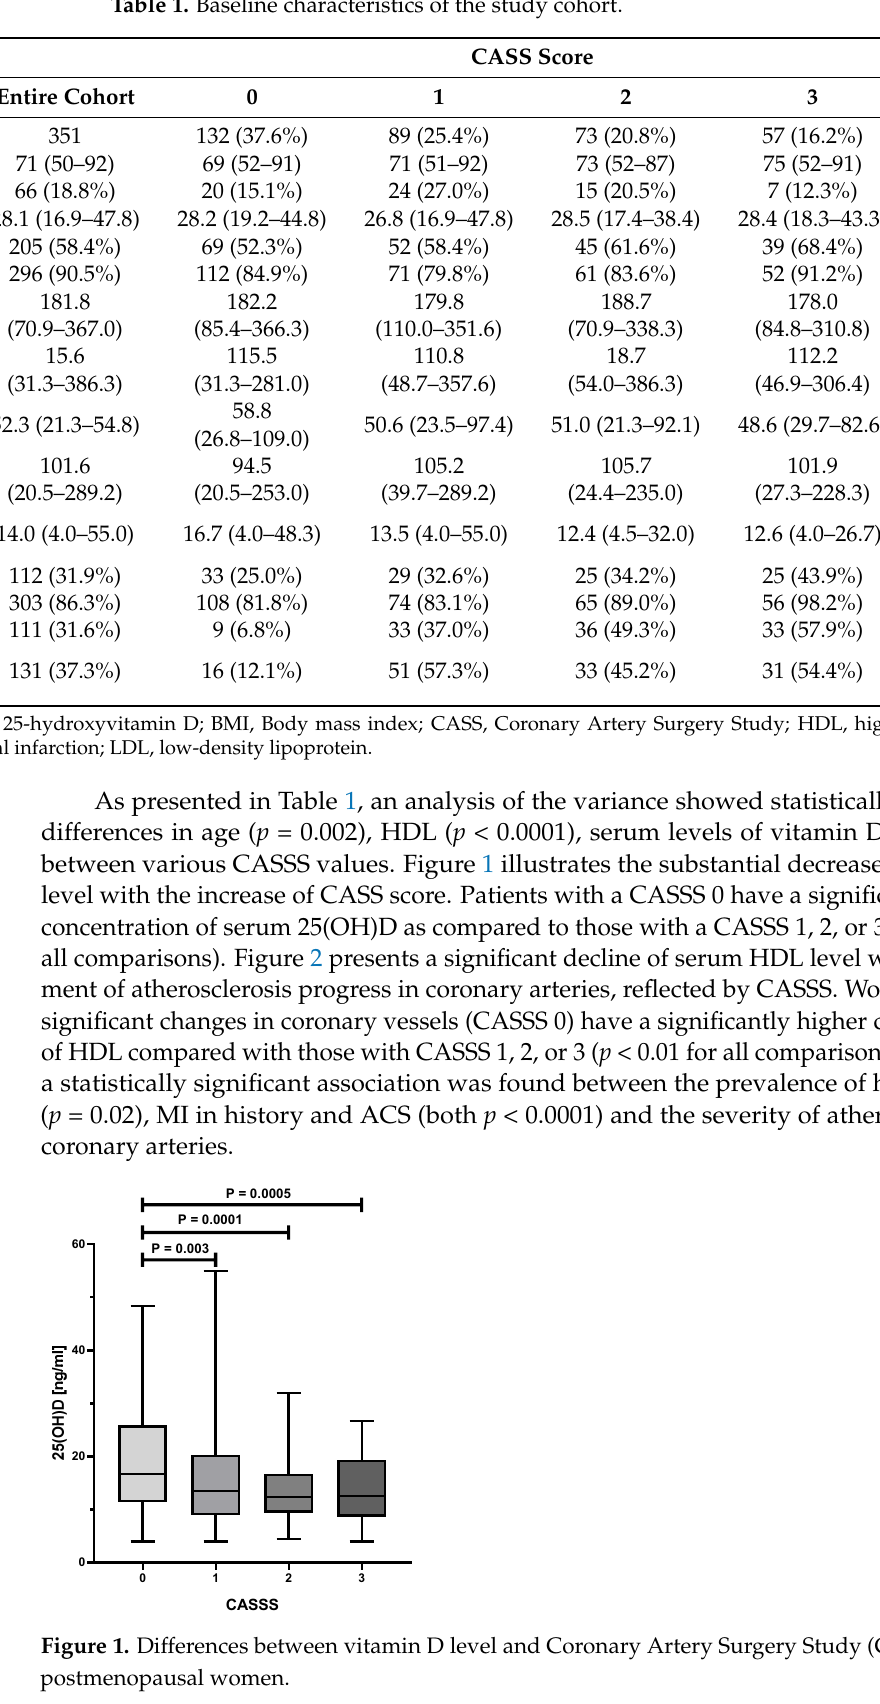
Figure 2. Association between HDL and CASS score. Multiple regression analysis of Poisson-distributed data was used to evaluate factors that may determine CASS score in a group of women over 50 years of age. The following determinants were included in the final analysis: age, BMI, serum 25(OH)D level, TC, LDL, HDL, TG, diabetes, hypertension, hyperlipidemia, history of myocardial infarction, and season during the examination. As presented in Table 2, statistically significant